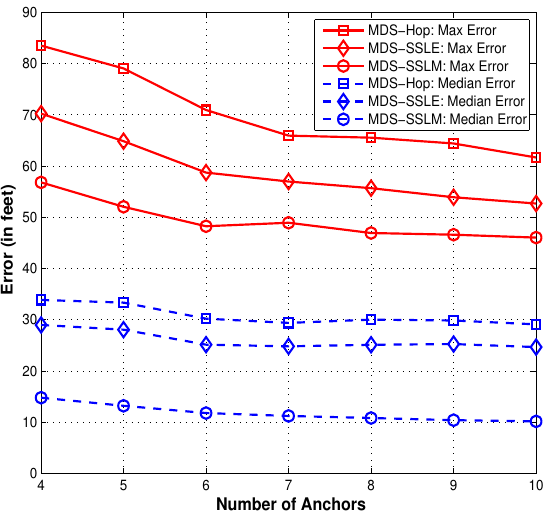
Figure 10. Statistical comparison of the three localization